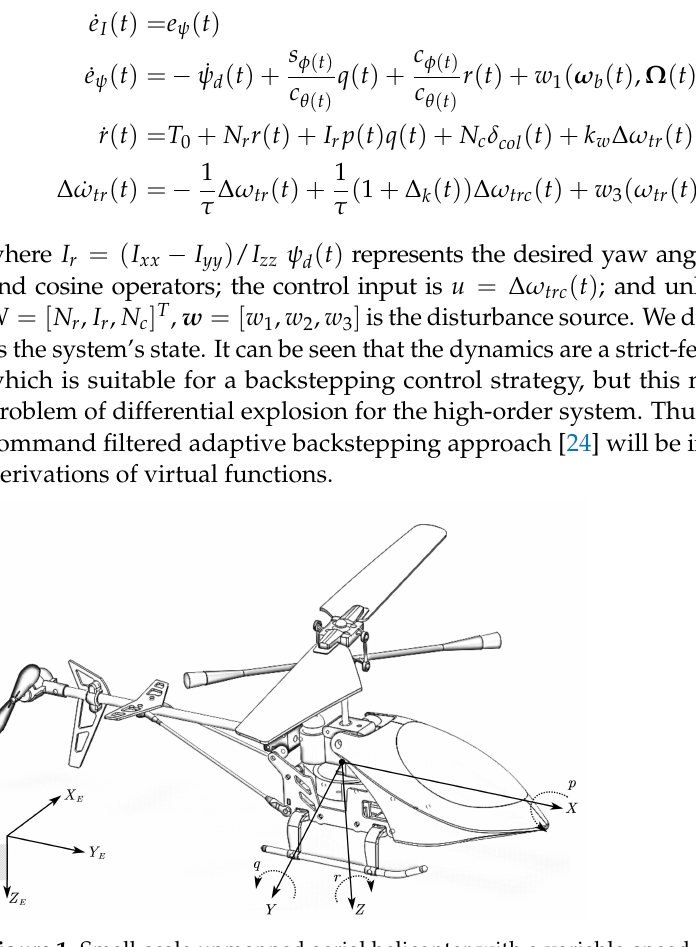
Figure 1. Small-scale unmanned aerial helicopter with a variable-speed tail